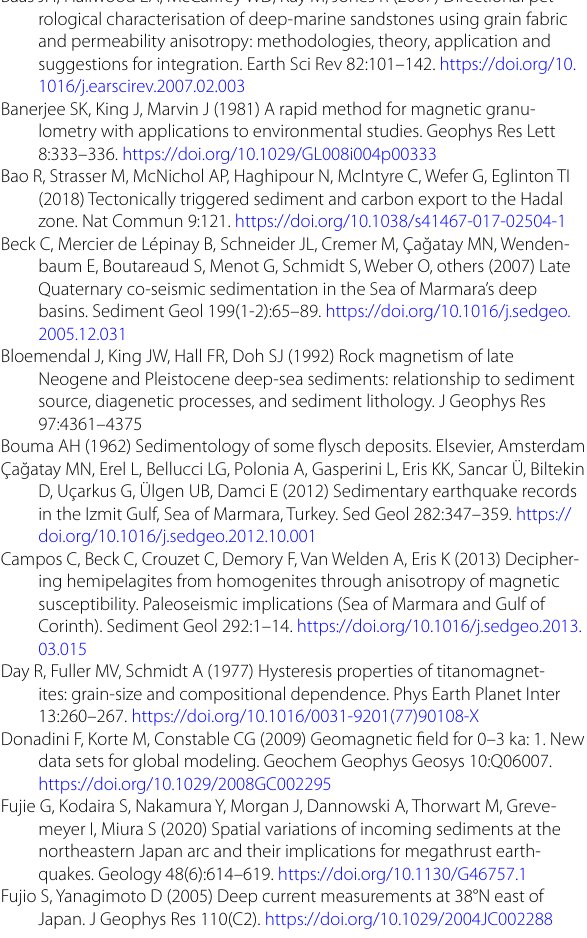
tion, dec: declination. Table S2: Declination, inclination, and age data of KS1416PC07 which are used for calculation of turbidite ages. Inc: inclina‑ tion, dec: